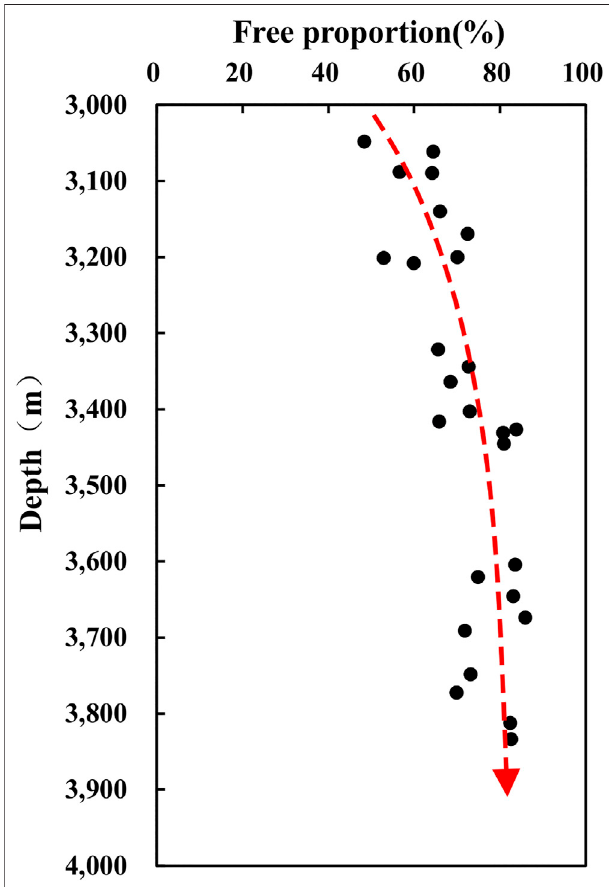
FIGURE 6 | Evolution trend of free oil ratio with depth.